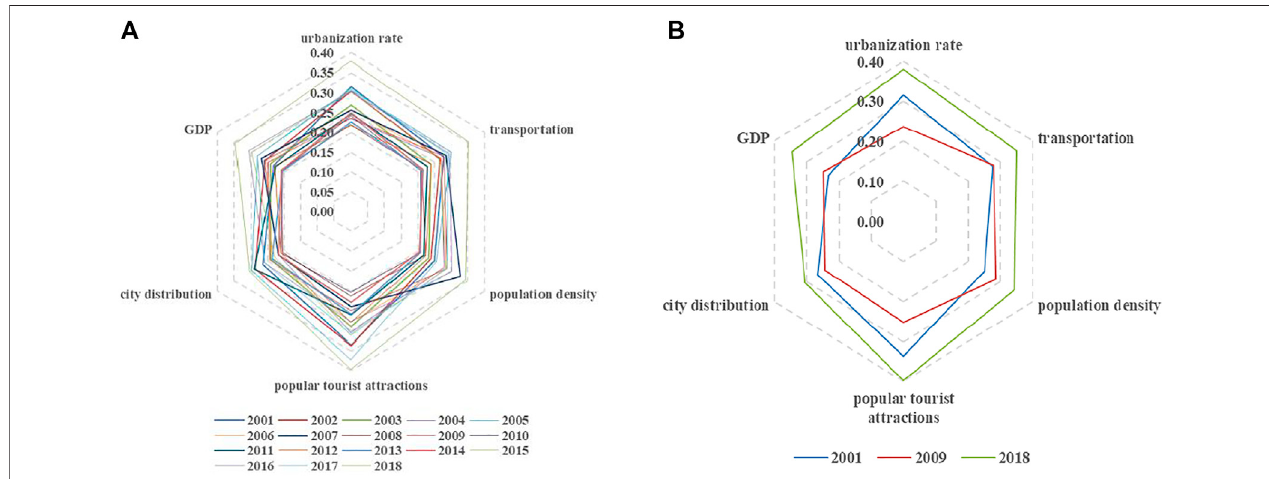
FIGURE 6 | Radar distribution of factor Q detection of the effects of different anthropogenic factors on vegetation cover in Guanzhong, Central China. (A) Overall distribution (from 2001 to 2018), (B) Partial distribution (2001, 2009, and 2018).